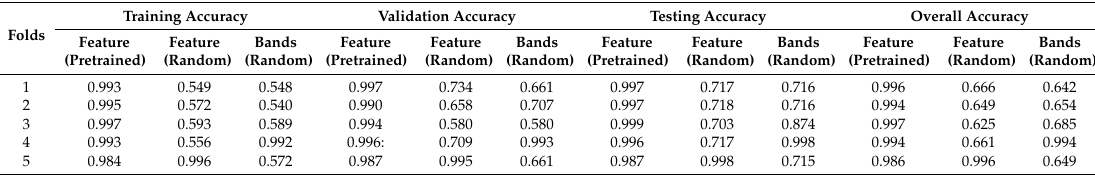
Table 2. Five-fold cross model training, validation, and testing